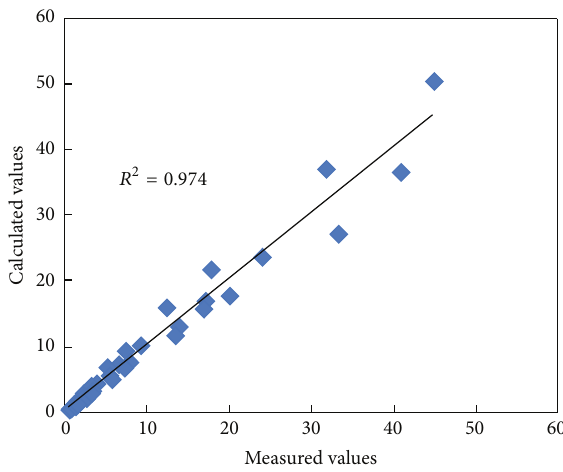
Table 3: 𝜆 and 𝜅 of asphalt at different temperature.